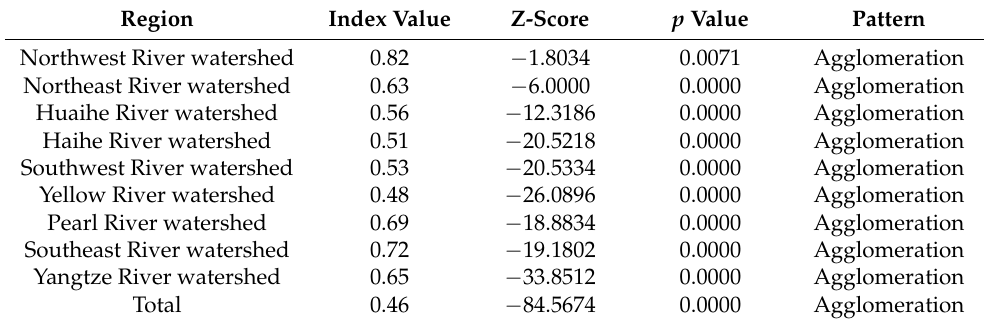
Table 3. The results of average nearest neighbor index.